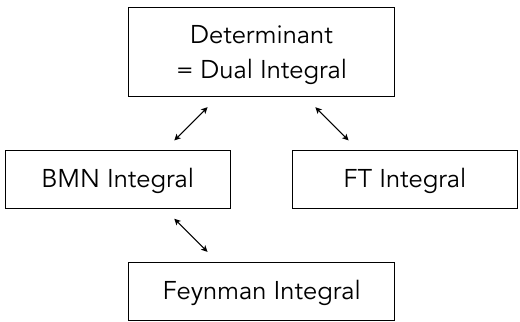
Figure 3 . Representations of the fishnet four-point integral. The Feynman integral was recently proved to be equivalent to the BMN integral (2.26) in refs. [16, 17]. In this paper we concentrate on the pyramid at the top and derive the determinant formula from the BMN and FT integrability- based